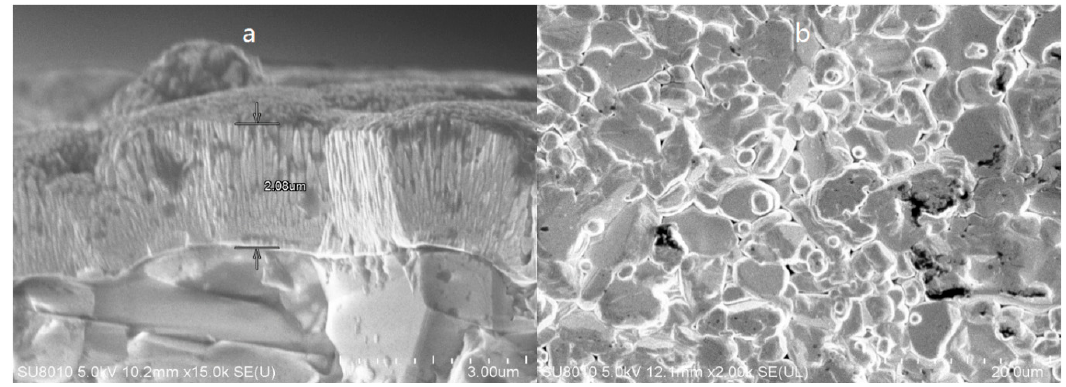
Figure 4. SEM images of the 95 wt% tungsten–5 wt% rhenium (W-5Re) section ( a ) and surface ( b ) after heat treatment.